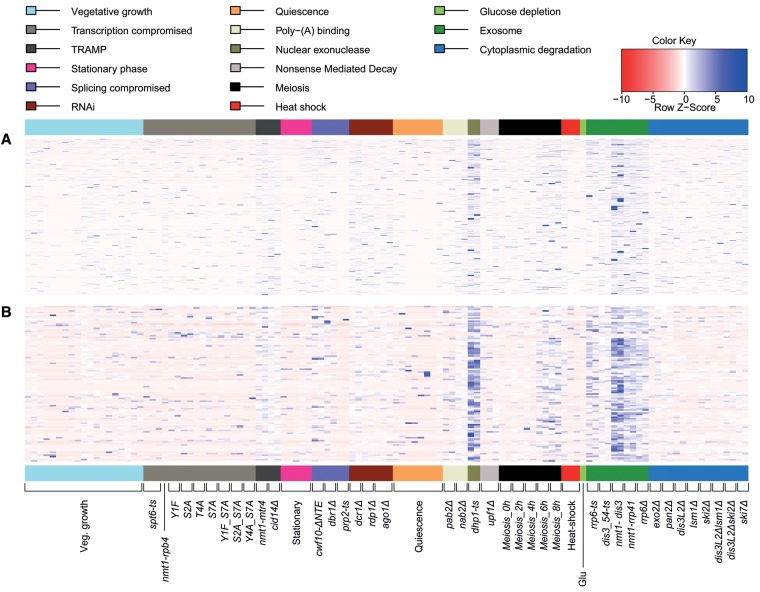
Splice variant-specific, local exon-skipping ratios (ESR) highlighting the stochastic nature of exon skipping. (A) Heatmap representing 2504 exon-skipping events for which both normal splicing and exon-skipping reads were identified in one or more samples (ratios provided in Supplemental Table S4). Physiological conditions or mutants as indicated below were grouped and color coded according to cellular function or condition tested. Maximum distance between rows (exon-skipping events) was determined using the “dist” function in R (method “maximum”), followed by hierarchical clustering using the “hclust” function. Row Z-score: Ratios in each row were scaled by subtracting the mean of the row from each value, followed by division of resultant values by the SD of the row, i.e., (local ESR value − row mean)/row SD. (B) As in A but showing local ESR for the high confidence set (111 exon-skipping events supported by nine or more exon-skipping reads in one or more samples). Only 107 exon-skipping events for which both normal and exon-skipping reads were identified in one or more samples are shown (Supplemental Table S5).